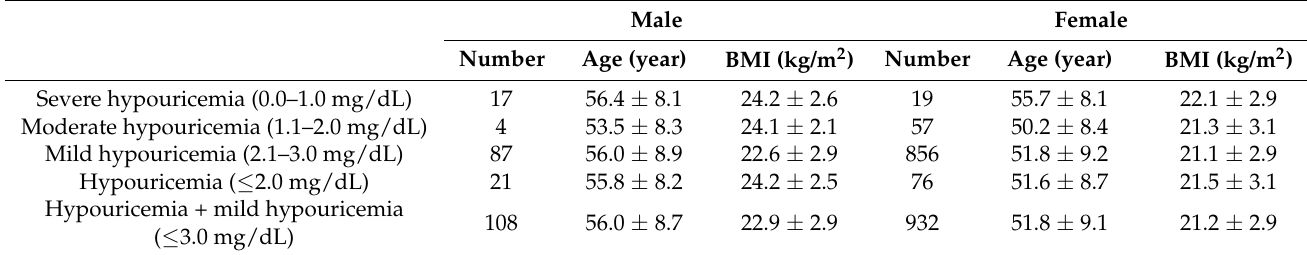
Table 2. Characteristics of 1040 hypouricemic individuals.